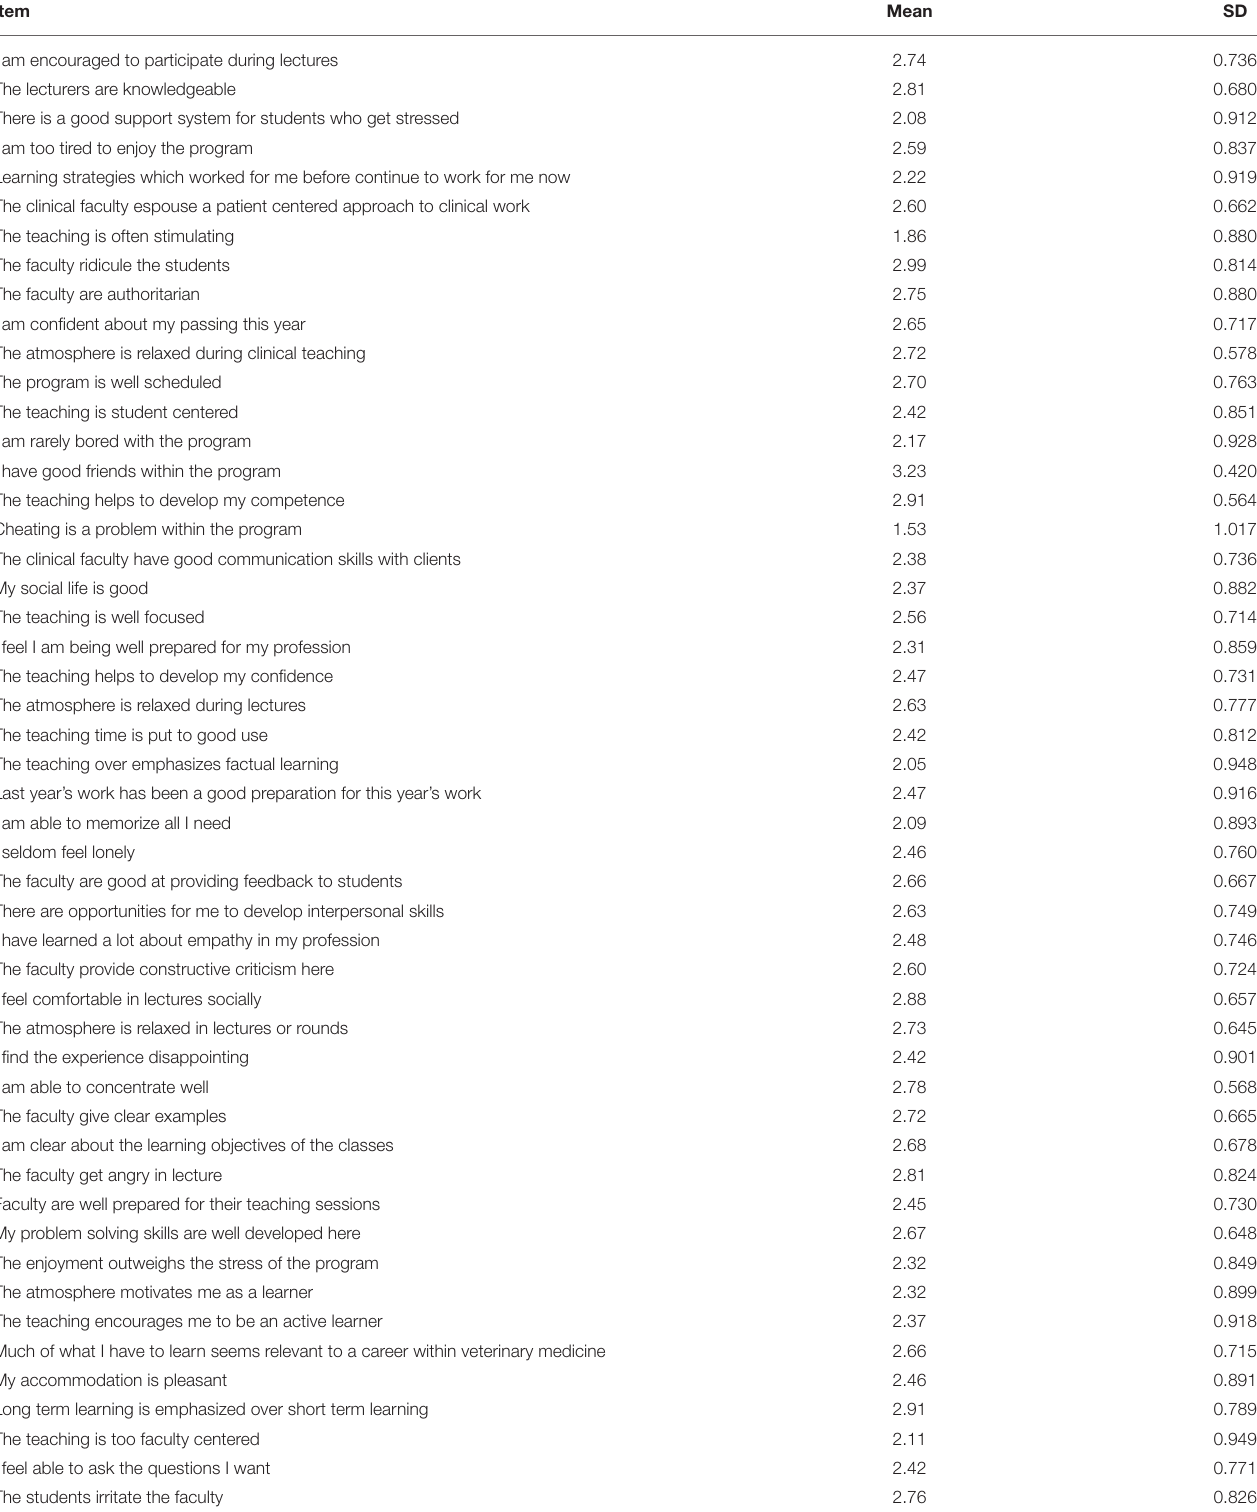
TABLE 2 | Mean and standard deviation for individual items of the DREEM.